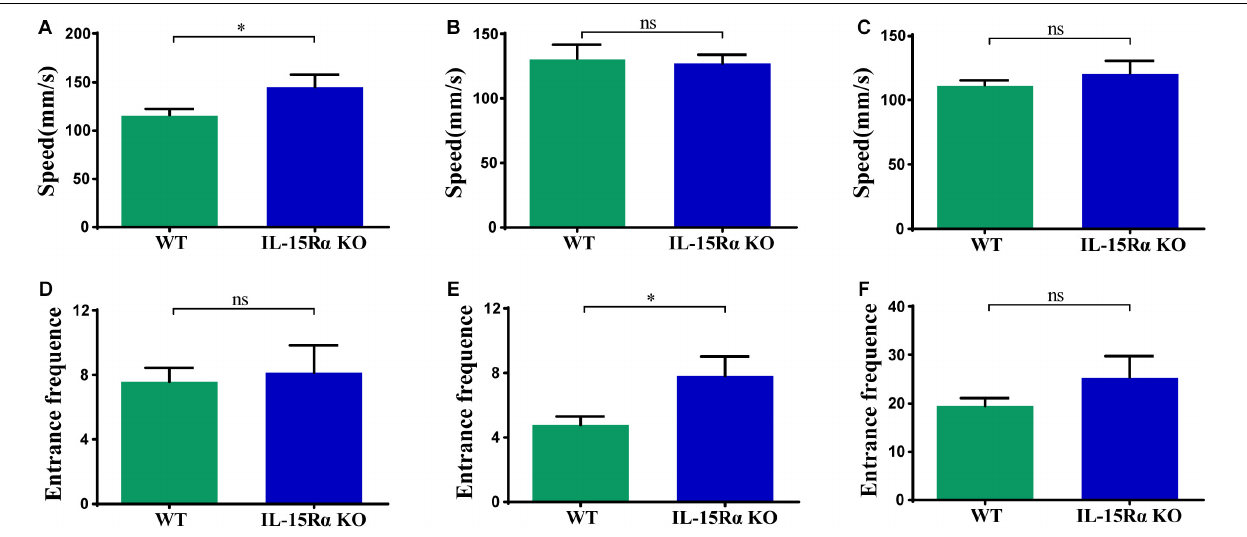
FIGURE 1 | Speed and entrance frequency behavior abnormalities after IL15R α knockout. (A) Histogram presents the average speed of IL15R α mice and wildtype mice in novel arm. (B) Histogram summarizes the average speed of IL15R α mice and wildtype mice in old arm (start arm and the other arm). (C) Histogram reveals the average speed of IL15R α mice and wildtype mice in total arm (novel arm, start arm, and the other arm). (D) Histogram presents the entrance frequency of IL15R α mice and wildtype mice in novel arm. (E) Histogram summarizes the entrance frequency of IL15R α mice and wildtype mice in old arm (start arm and the other arm). (F) Histogram reveals the entrance frequency of IL15R α mice and wildtype mice in total arm (novel arm, start arm, and the other arm). Average speed is computed from total distance traveled in certain region divided by total time in certain region. The results are depicted as the mean ± SD from eight biological